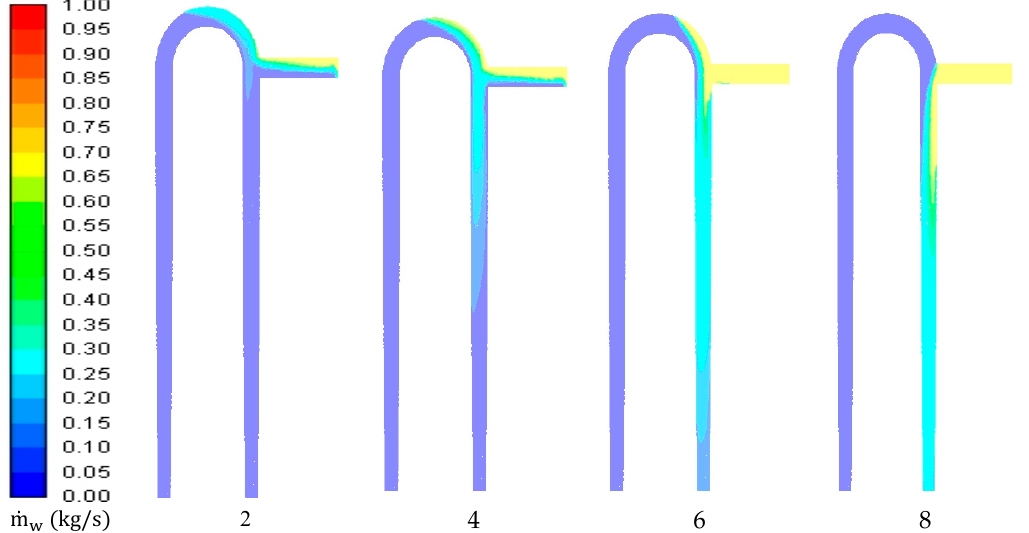
Figure 22. Vapor volume fraction contours at different flow ratios and X (cid:2933) = 662.96, α (cid:2923) = 0.7 , X (cid:2932) = 0.5 .